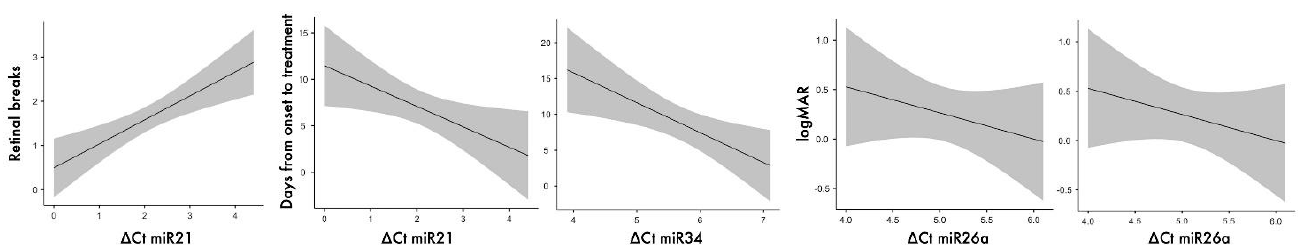
Figure 1. Main results from regression analyses; grey area around the linear tendency line is delimited by standard error.